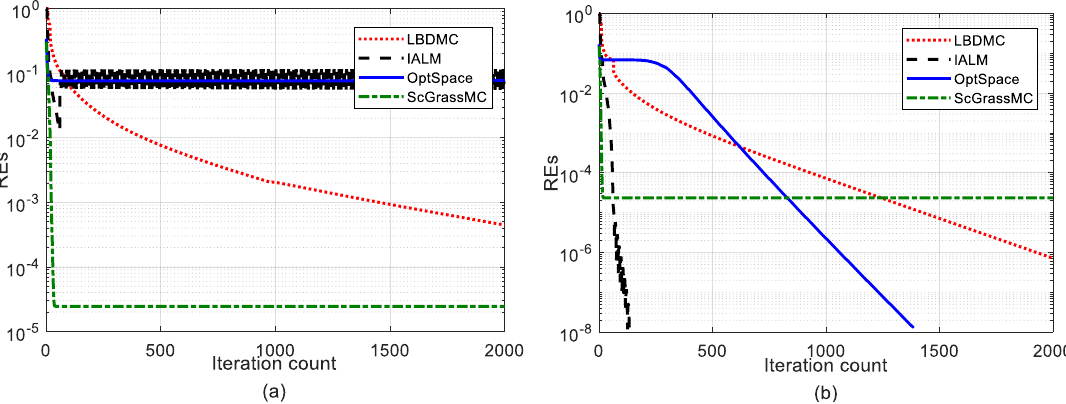
Figure 2. Comparison of convergence. The maximum number of iterations is fixed at 2000, and the tolerance is fixed at 10 − 8 ; that is, stopping iterations once REs < 10 − 8 : ( a ) The sampling rate is fixed at 30%; ( b ) The sampling rate is fixed at